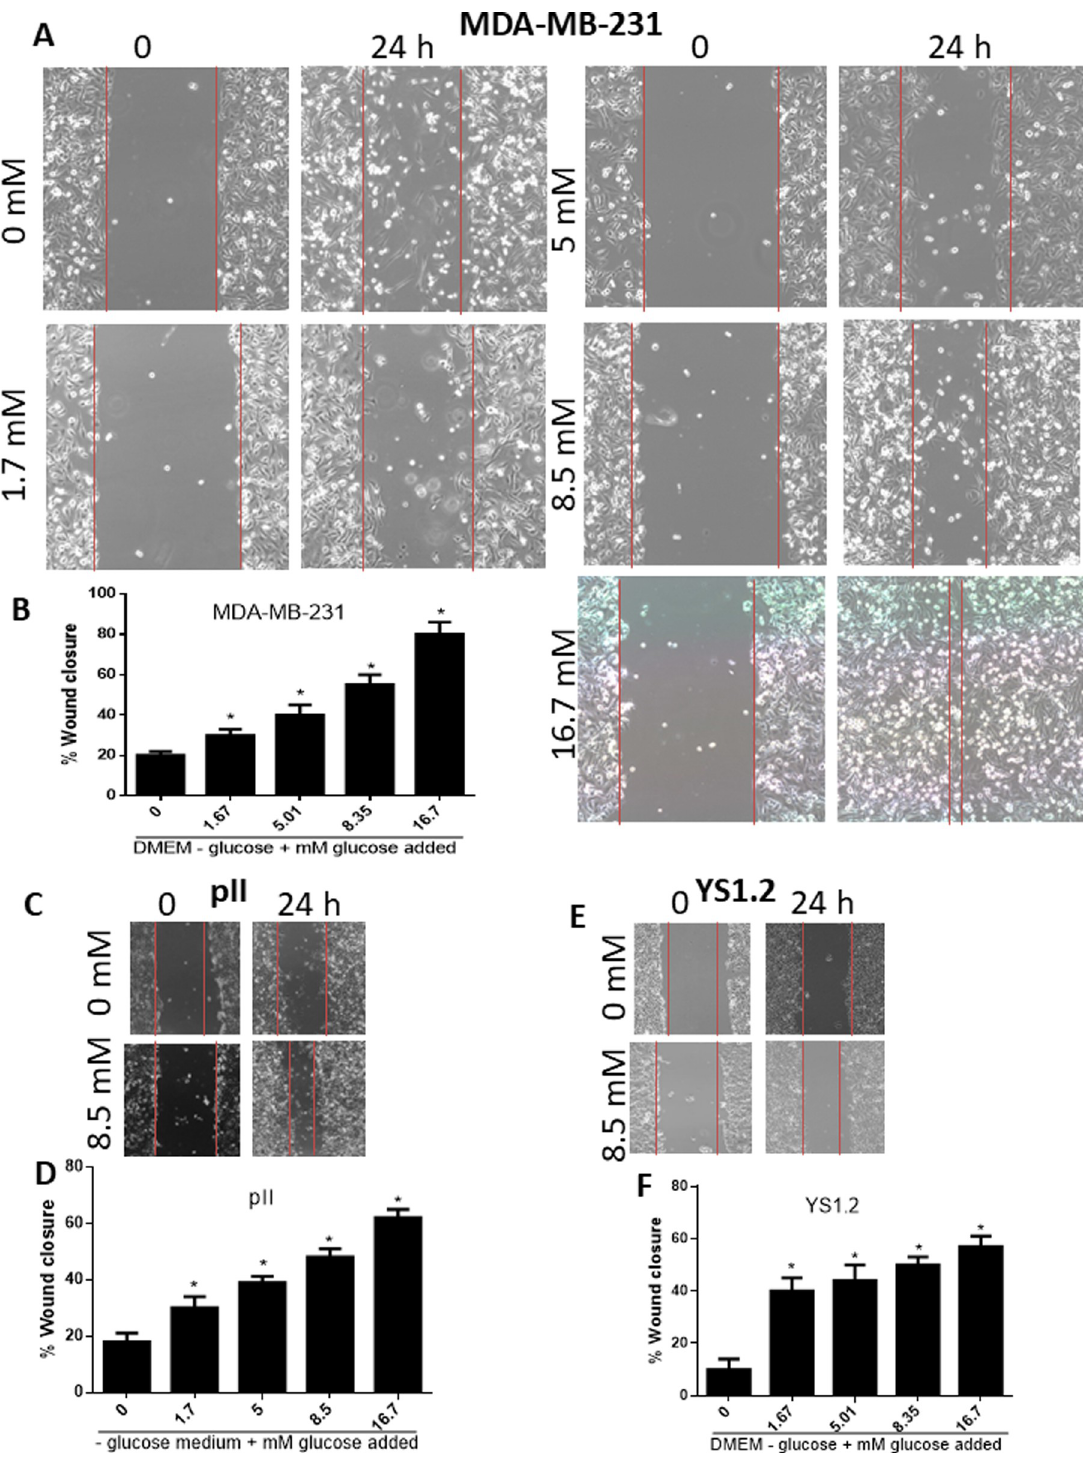
Fig 3. Effect of glucose concentration on breast cancer cell motility. Cells were cultured to confluency in + glucose medium. The medium was then changed to–glucose medium + glucose additions as indicated. A scratch was made through the cell monolayer and the width measured immediately and after further 24h incubation. Panels A-B for MDA-MB-231 cells, panels C-D for pII cells, and panels E-F for YS1.2 cells. Histobars represent means ± SEM for each condition. � denotes significant difference from cells cultured in—glucose medium, with p <